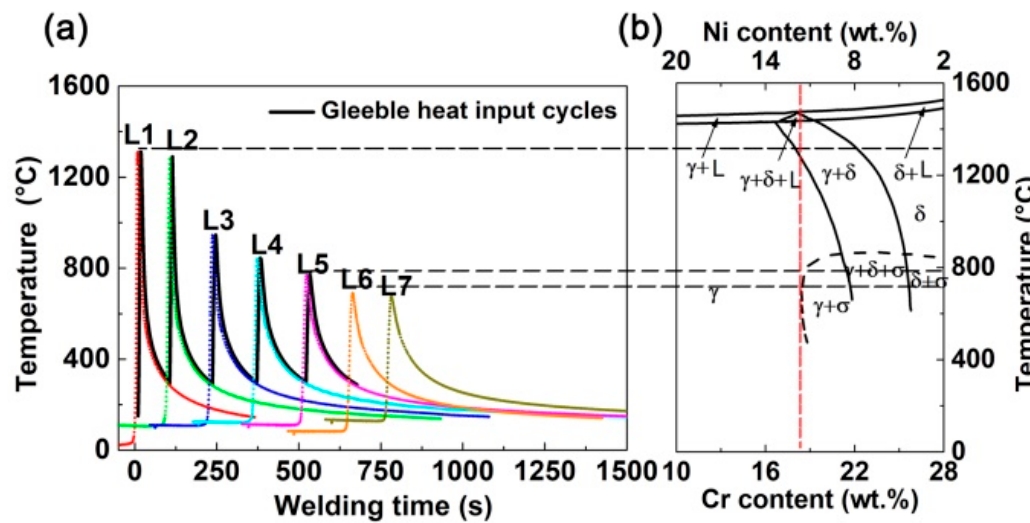
Figure 7. Heat input of the Gleeble weld-simulator from the temperature field measured at the T1 position in the 70 wt.% Fe pseudo binary phase diagram of the Fe–Cr–Ni alloy with the Cr/Ni ratio: ( a ) heat input for Gleeble weld-simulator; and ( b ) 70 wt.% Fe pseudo binary phase diagram of Fe–Cr–Ni.